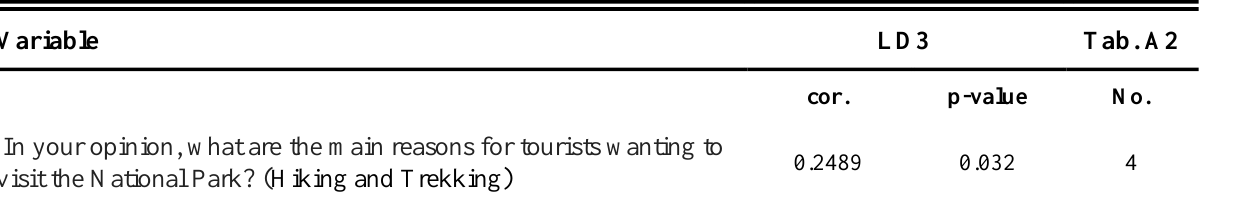
question, correlation and p-values are shown, together with the relative question number reported in Tab.